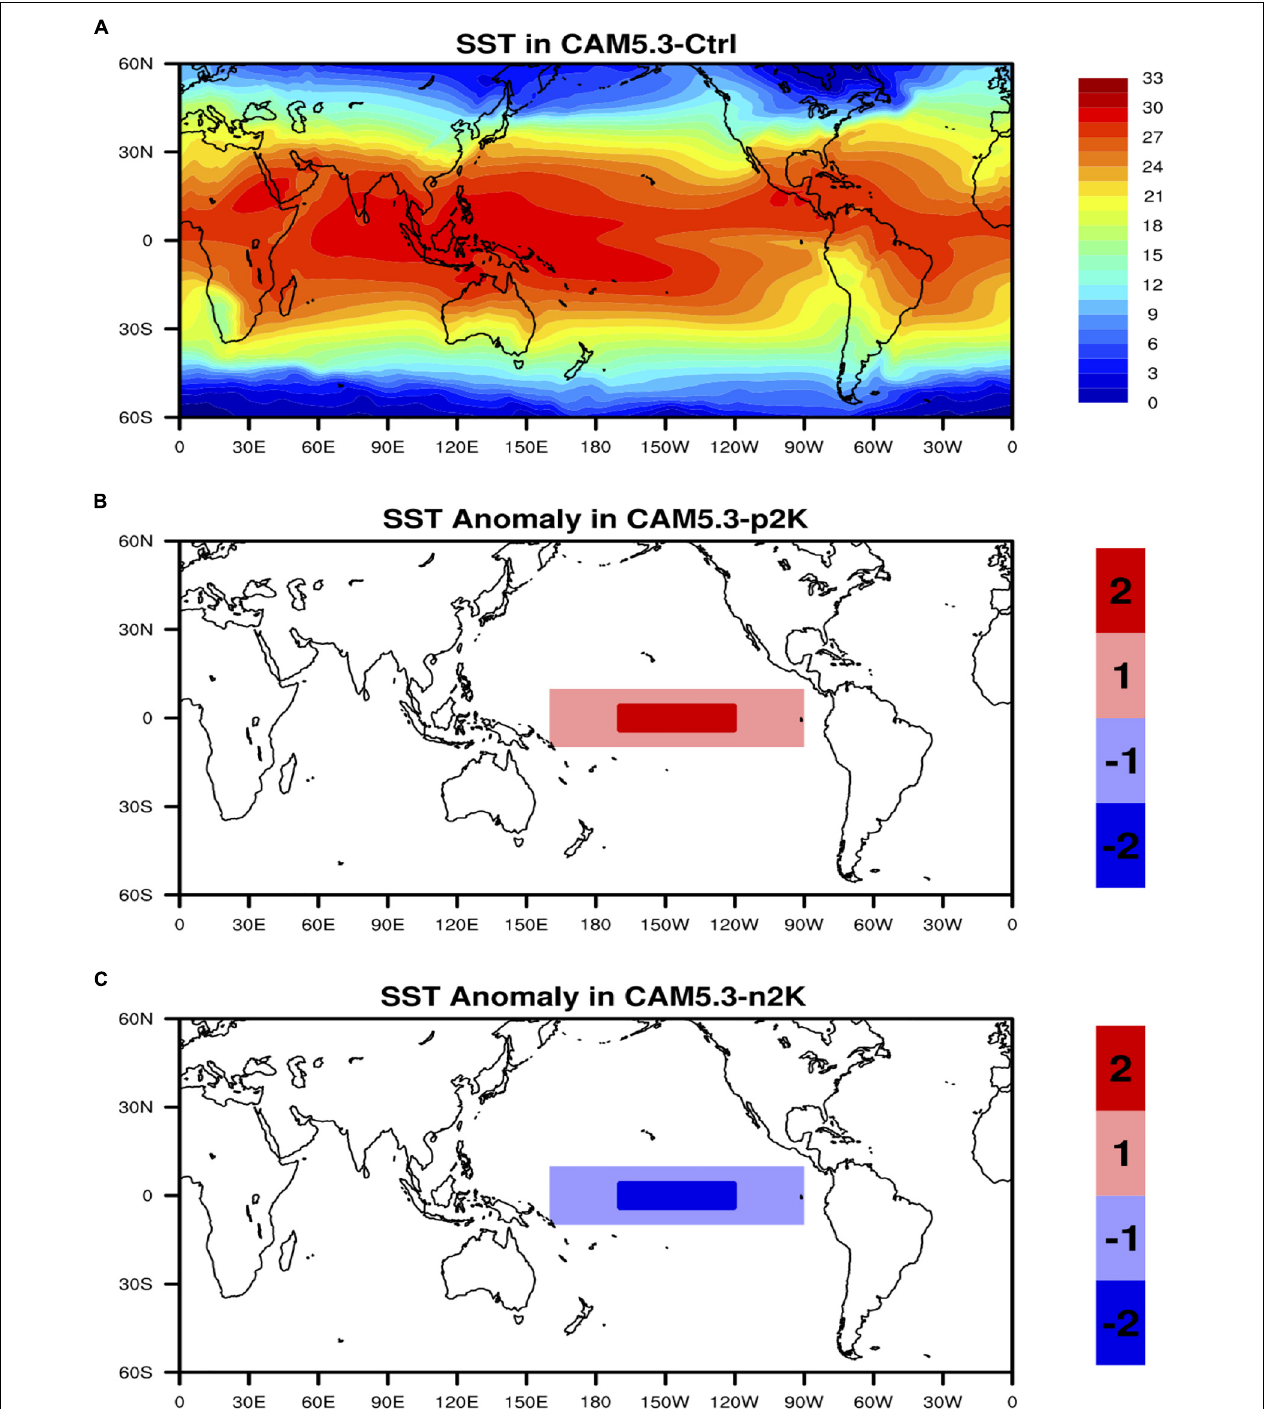
FIGURE 2 | (A) Global distribution of annual mean SST used in the control run. (B) The SST anomaly used in the +2K run with respect to control run. (C) The SST anomaly used in the –2K run with respect to control run. Unit of SST is ◦ C.